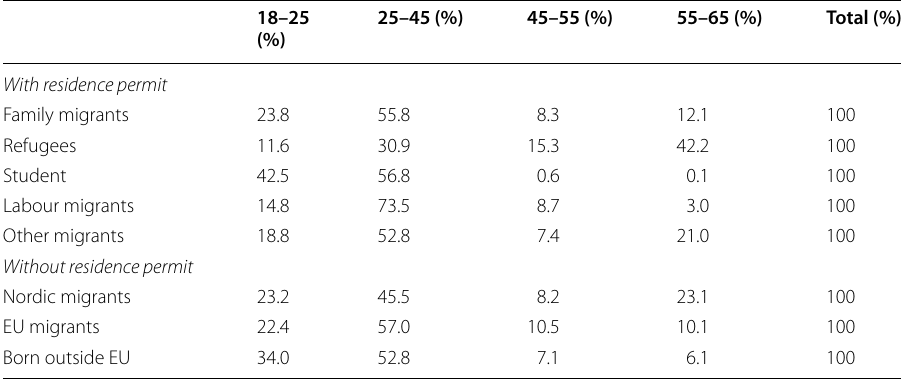
Table 3 Age distribution of migrants who remain unregistered ten years after arrival, by mode of legal